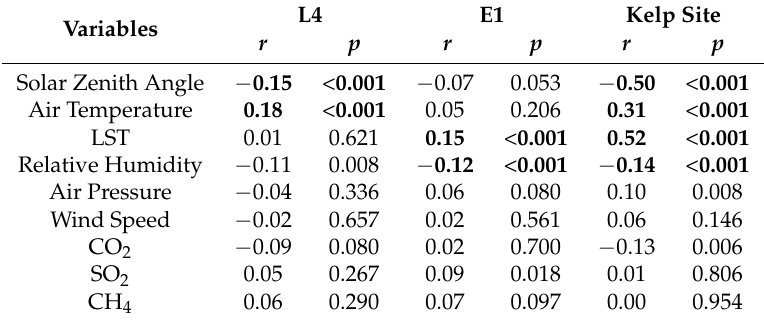
Table 2. Correlations between a range of variables and the differences in SST between AVHRR SST N and in situ SST data at three sites (L4, E1 and the kelp site). Bold indicates significant correlations ( p < 0.001) . L4 E1 Kelp Site Variables r p r p r p Solar Zenith Angle − 0.15 < 0.001 − 0.07 0.053 < 0.001 0.18 <